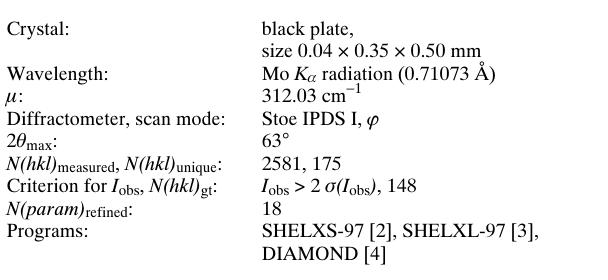
Table 1. Data collection and